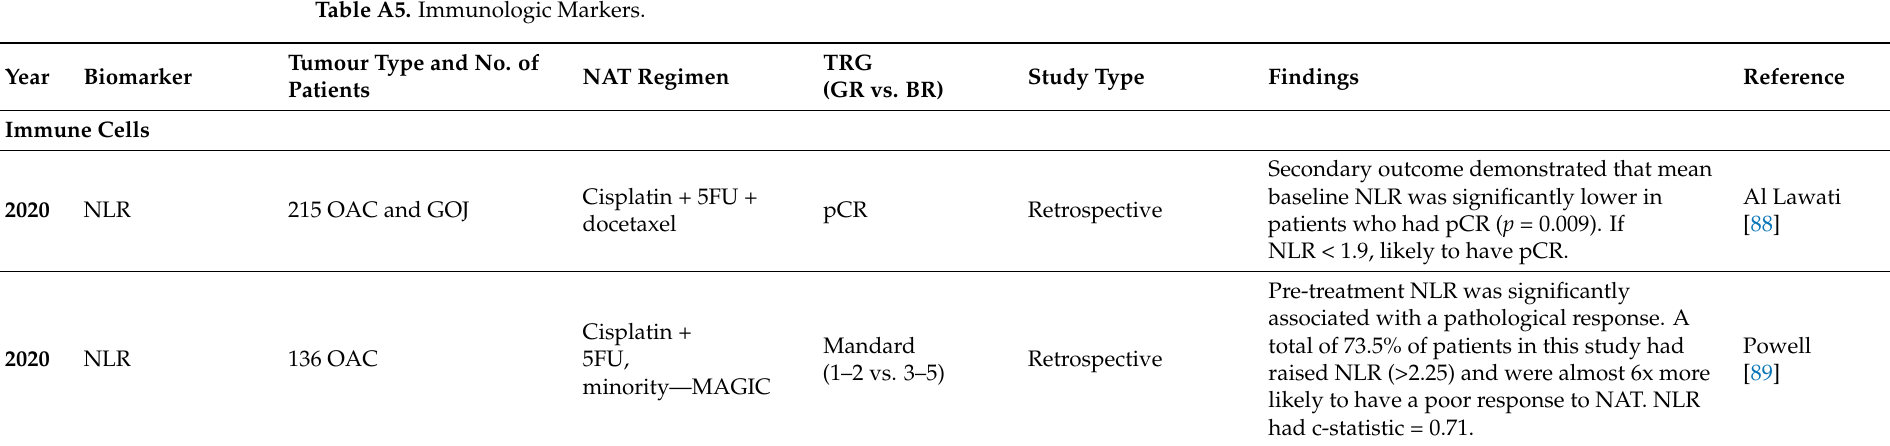
Table A5. Immunologic